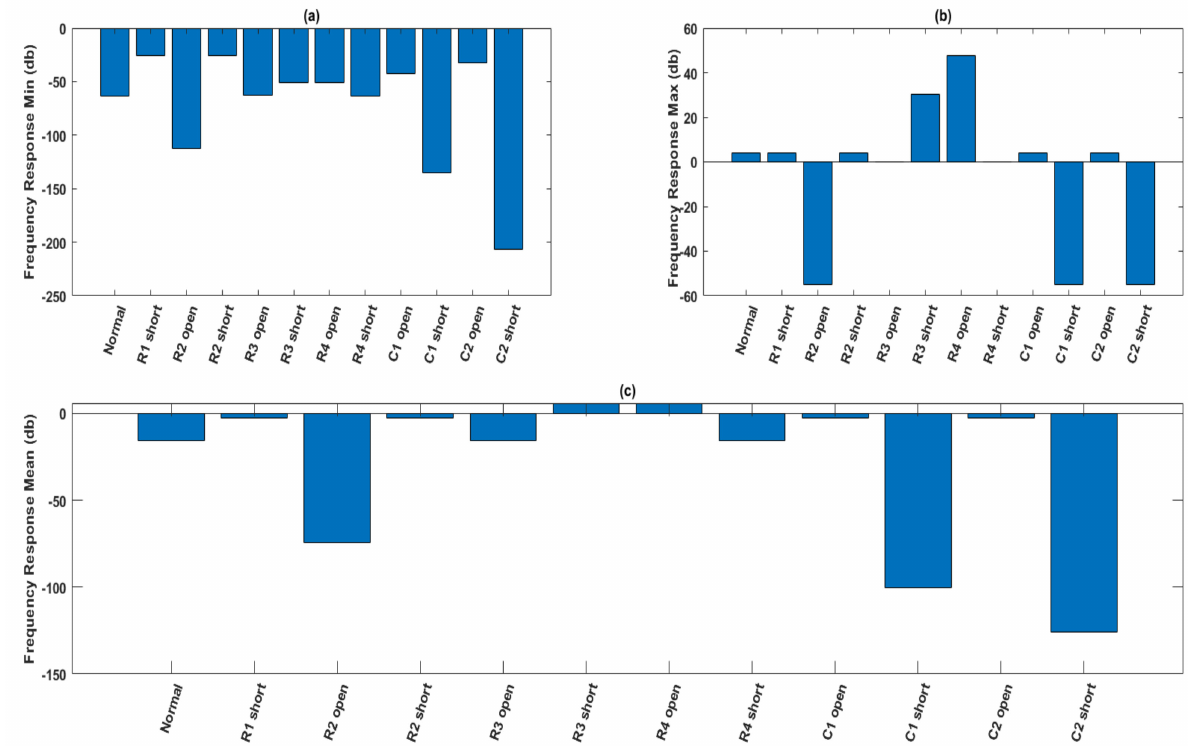
Figure 5. The statistical analysis of the circuit frequency responses. ( a ) Minimum values of each fault. ( b ) Maximum values of each fault. ( c ) Mean values of each